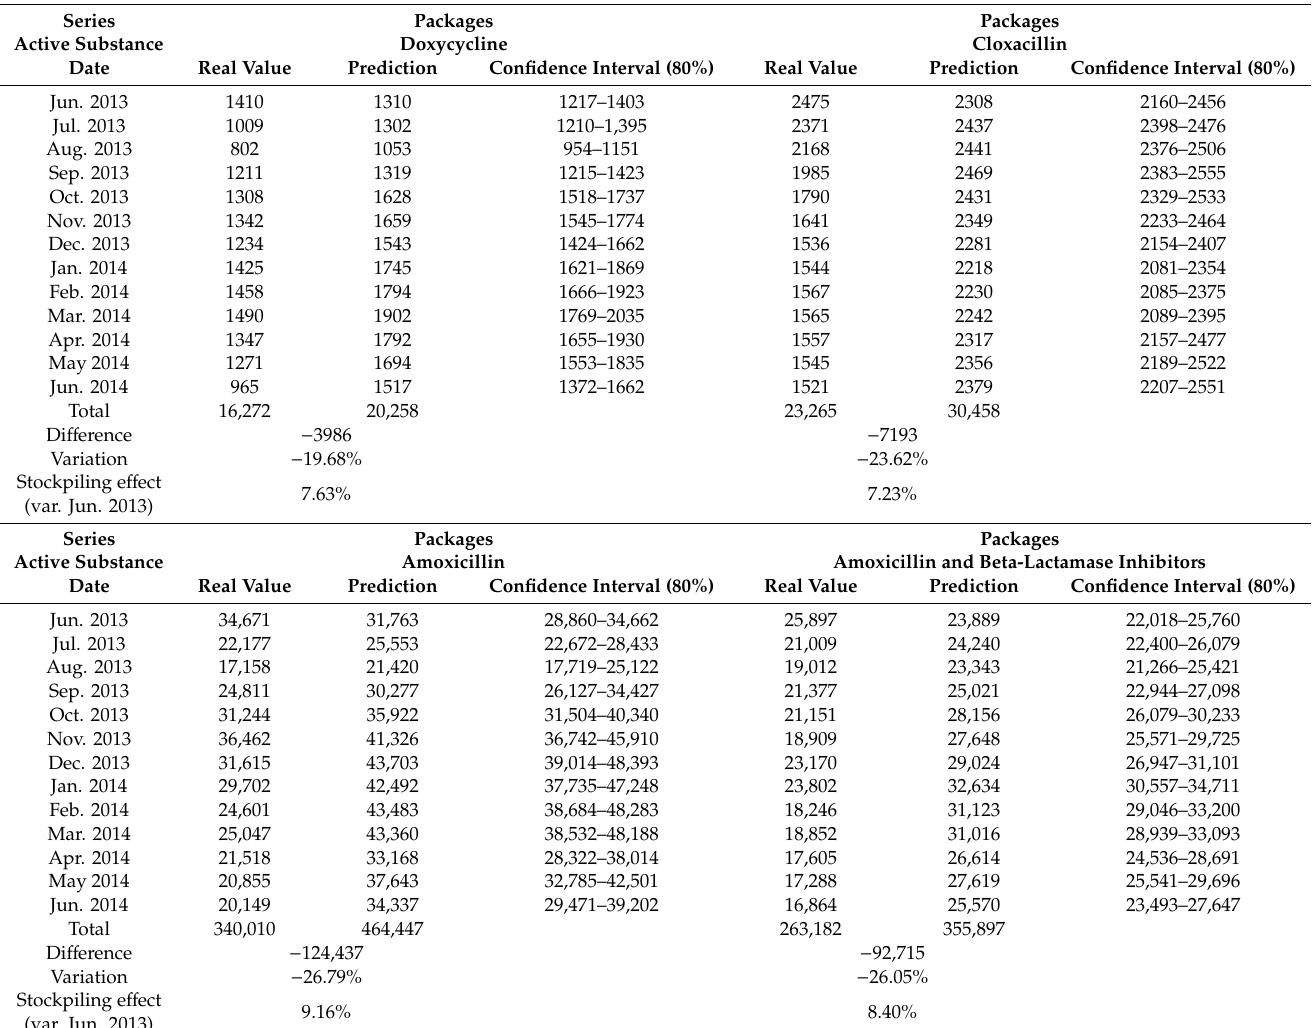
Table A3. Saving of the RDL no. 16 / 2012 introduction by active substance (predictions with the ARIMA models in Table